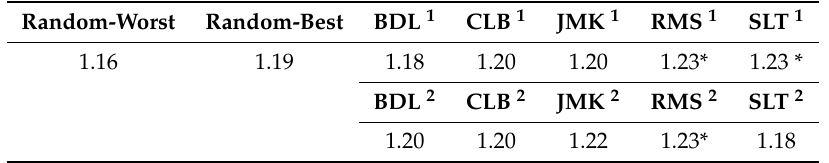
Table 4. Mean PESQ Results for CLB voice. Higher values represent better results. * is the best result. The superscript 1 means that the LSTM post-filter was pre-trained as ANN using natural parameters, while the superscript 2 means the same procedure applied with synthetic parameters.